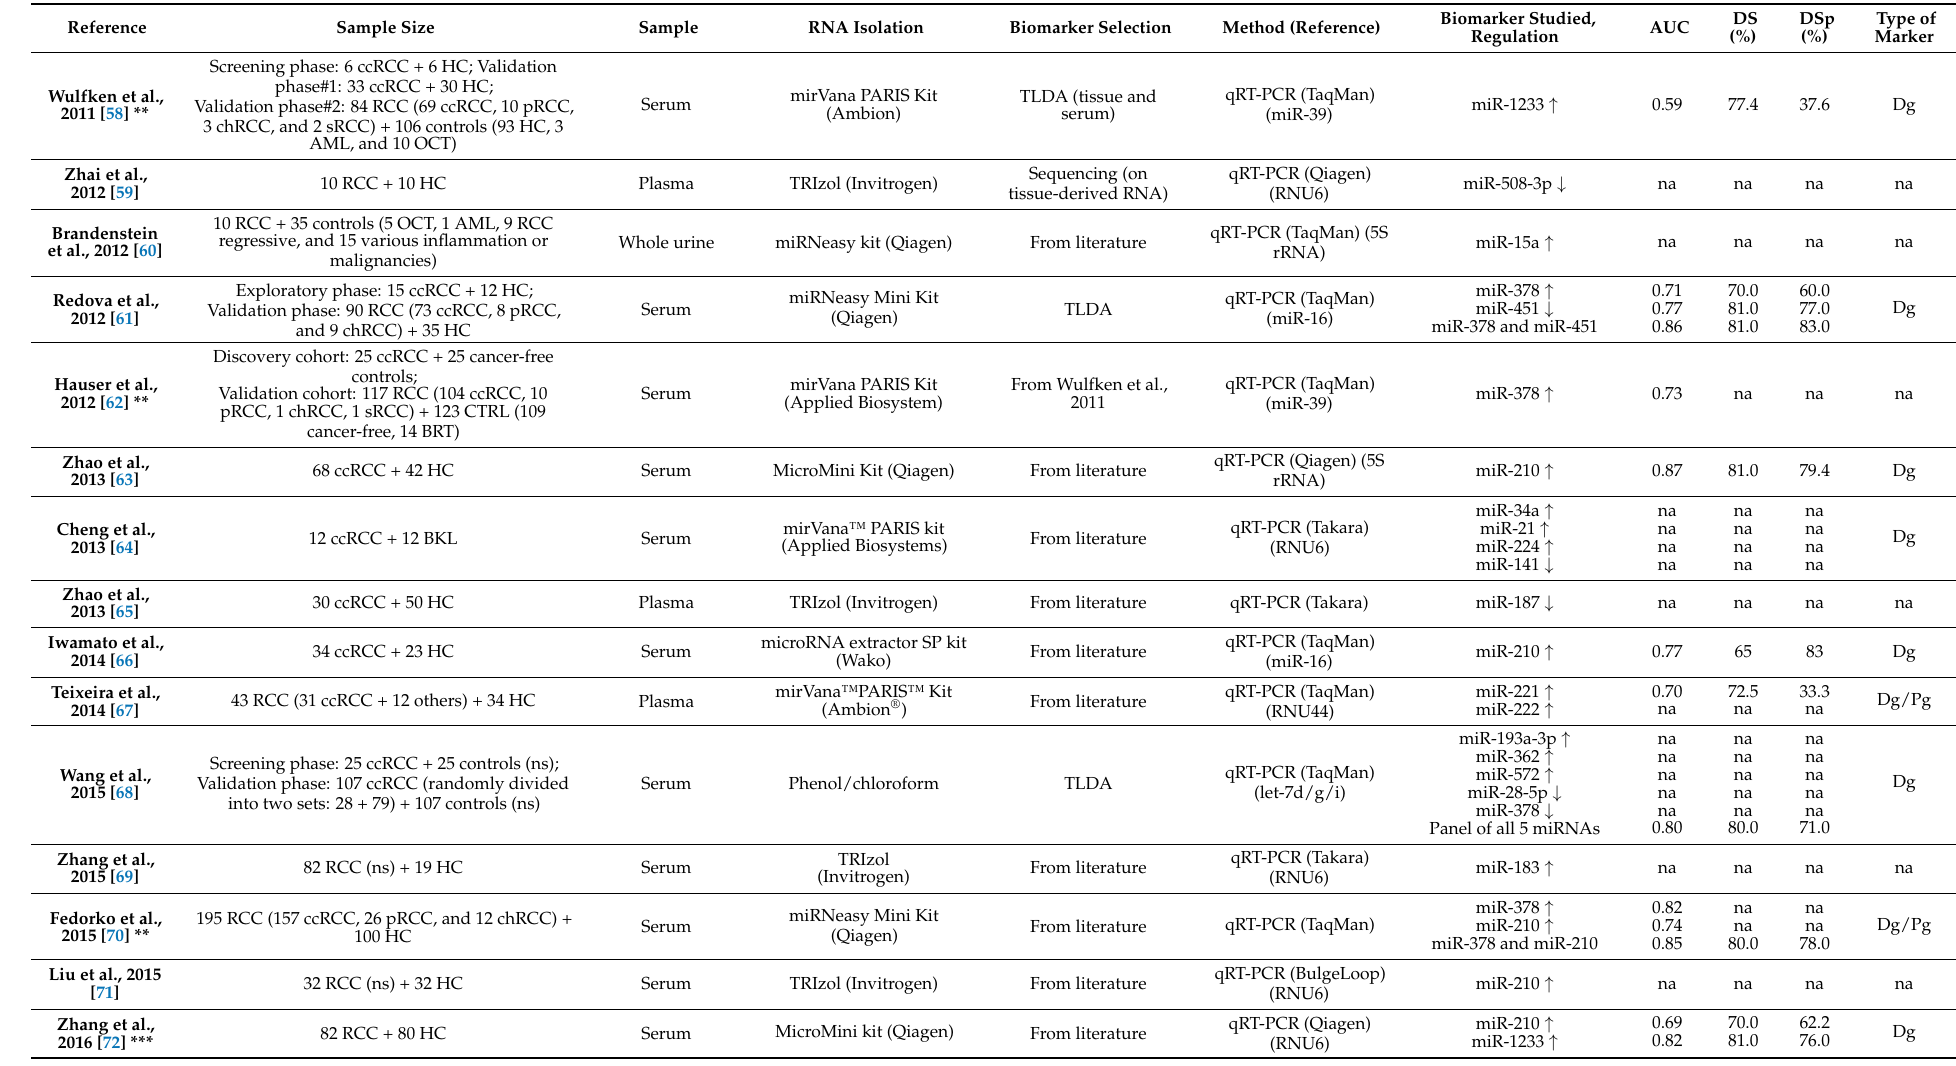
Table 2. Studies concerning microRNAs in biofluids as potential biomarkers of renal cell